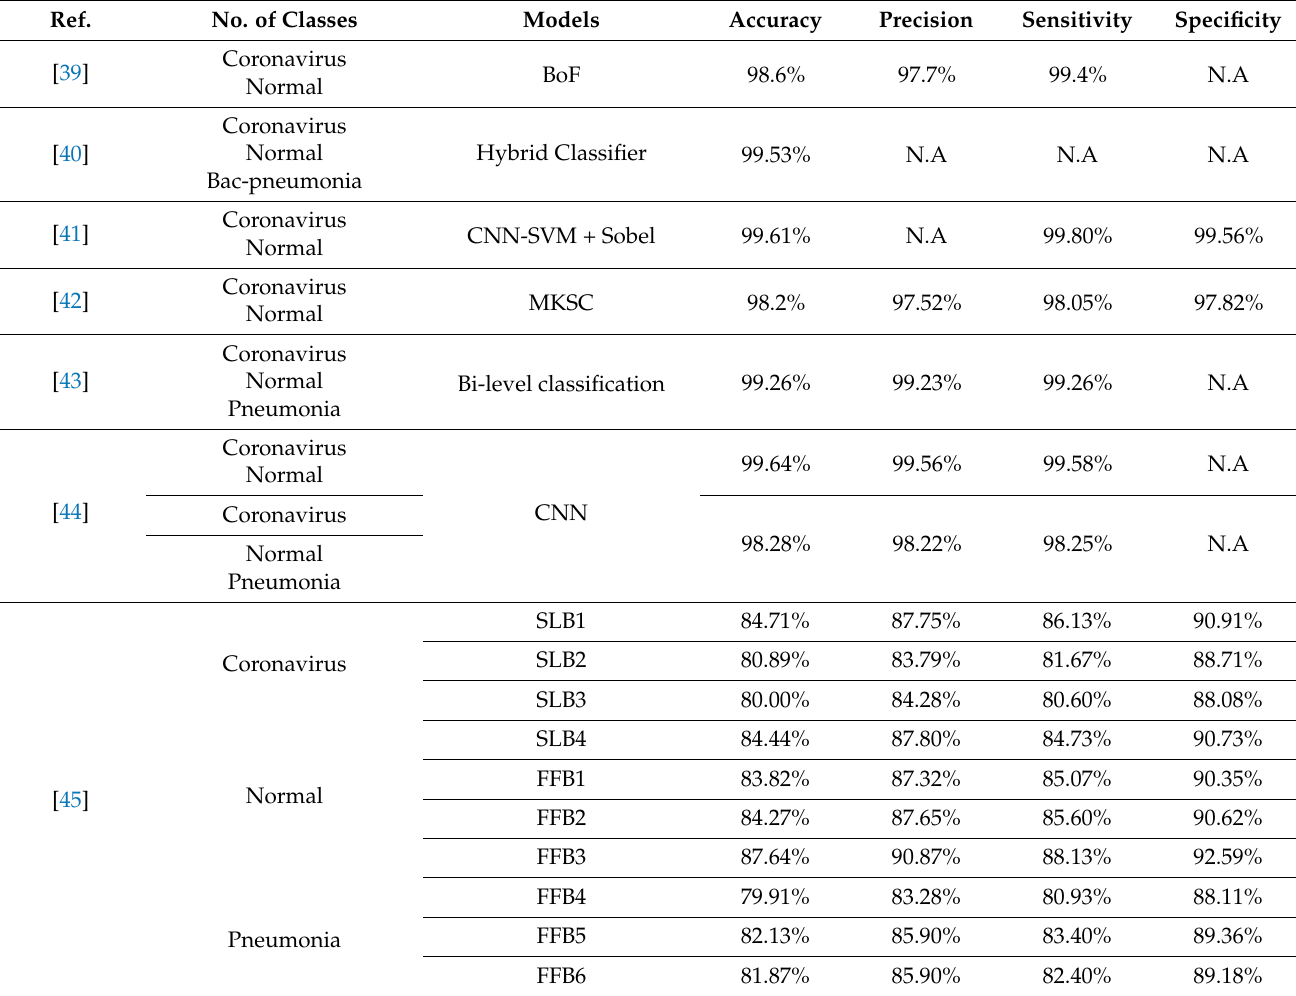
Table 1. Summary of related